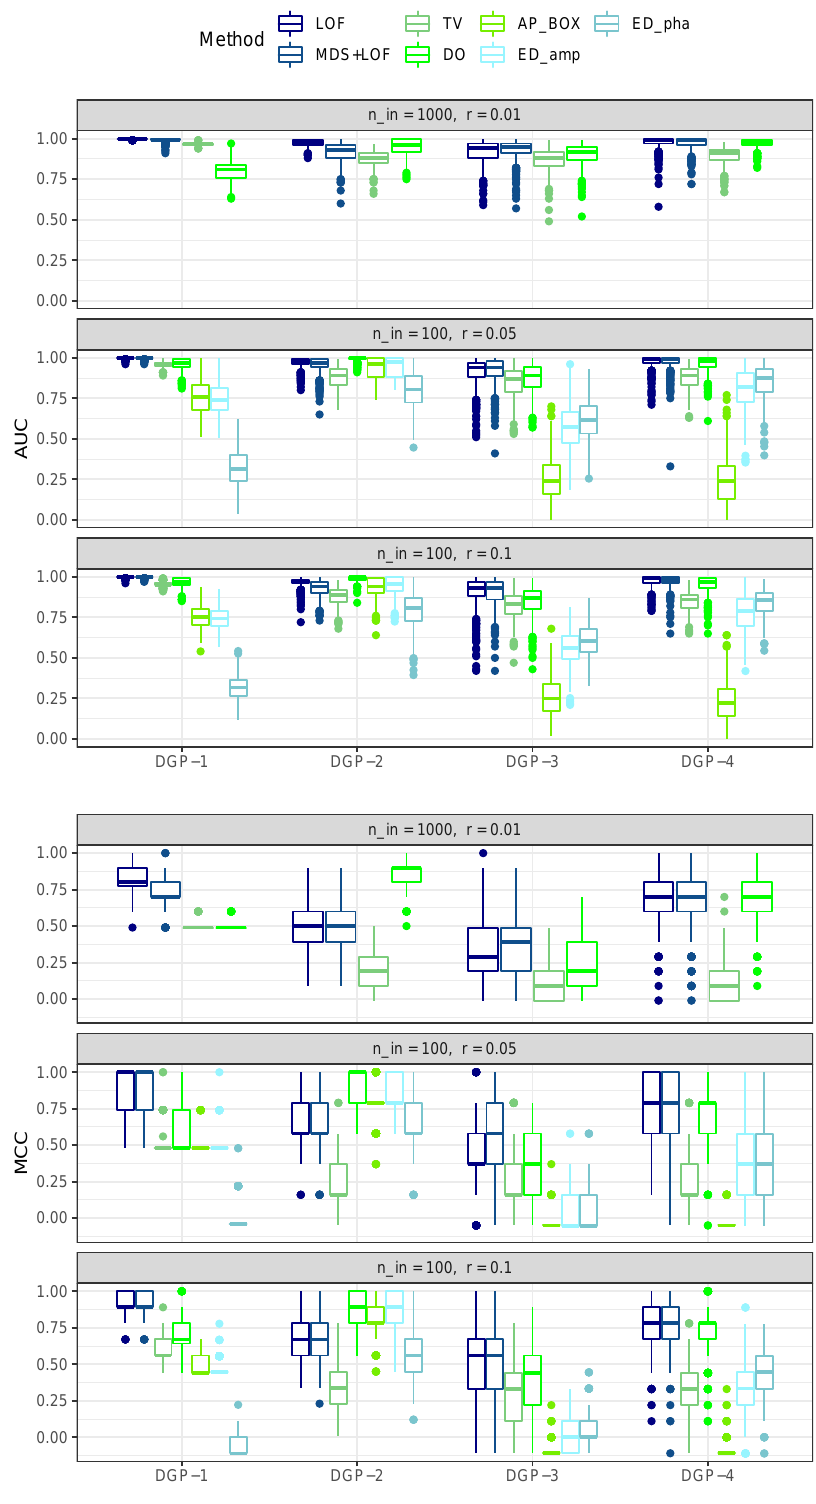
Figure 9. Distribution of the AUC and MCC over the 500 replications for the different data-generating processes (DGPs), outlier-detection methods, and outlier ratios r